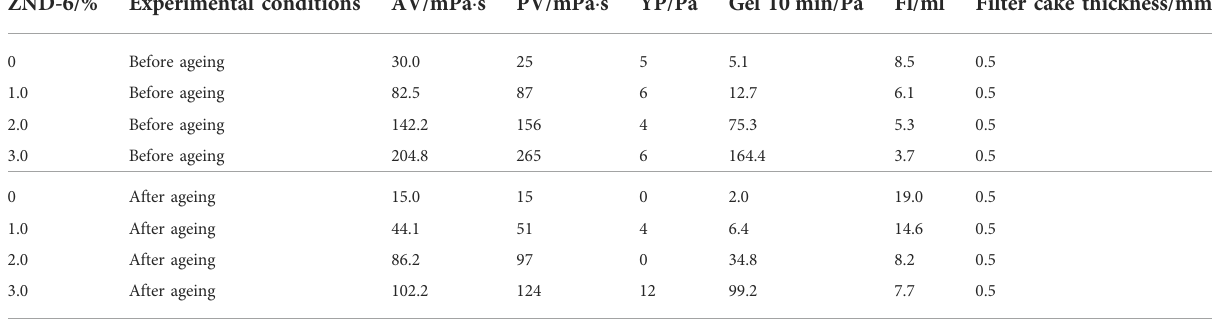
TABLE 1 Compatibility of ZND and NaCl drilling fl uids (150 ° C for 16 h aging).